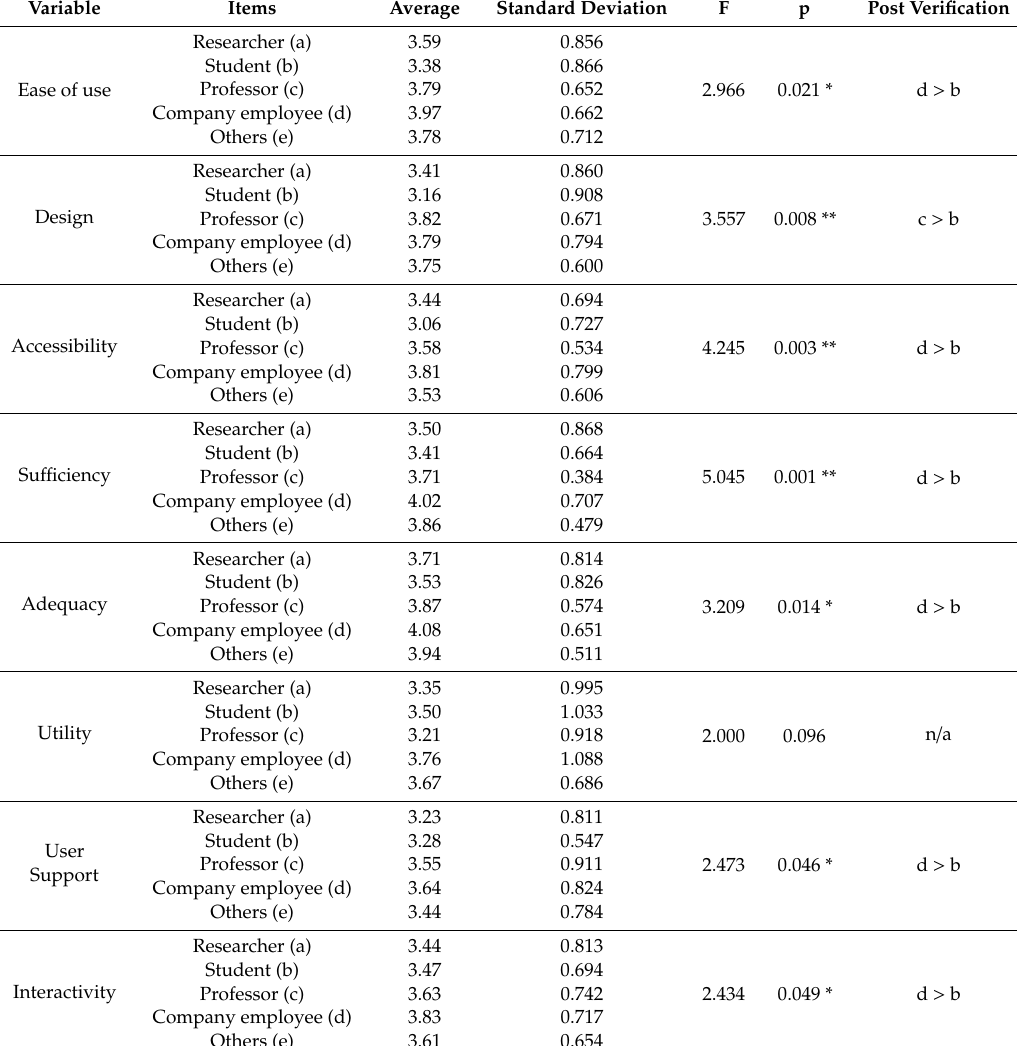
Table 7. Comparison of satisfaction by occupation